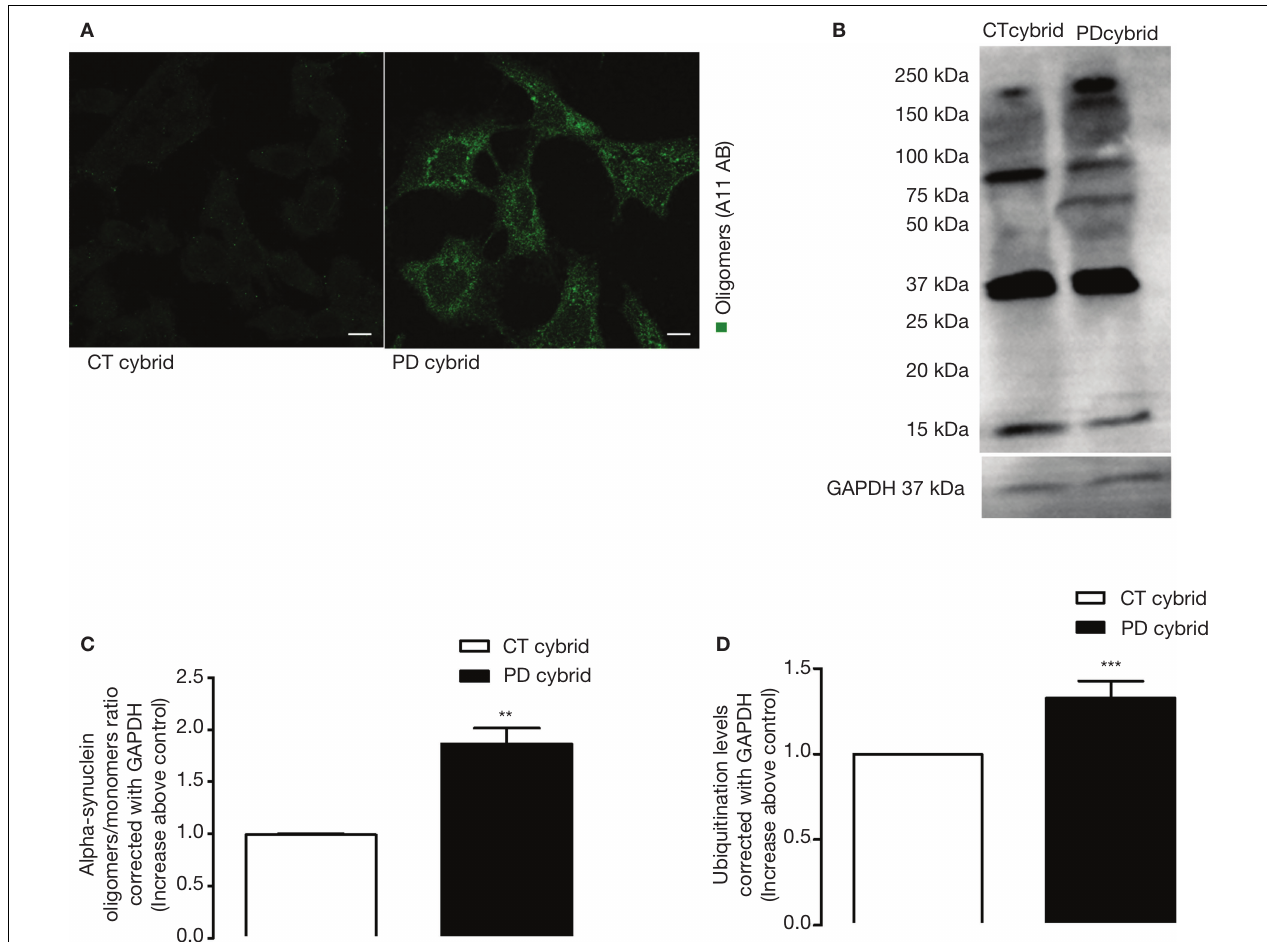
and monomer levels corrected for GAPDH. The ratio is increased in the PD cybrid line. (D) Ubiquitination densitometry analysis showed the PD cybrid cells had more ubiquitinated protein. ** P < 0.01 and *** P < 0.001, signifi cantly different when compared to the CT cybrid